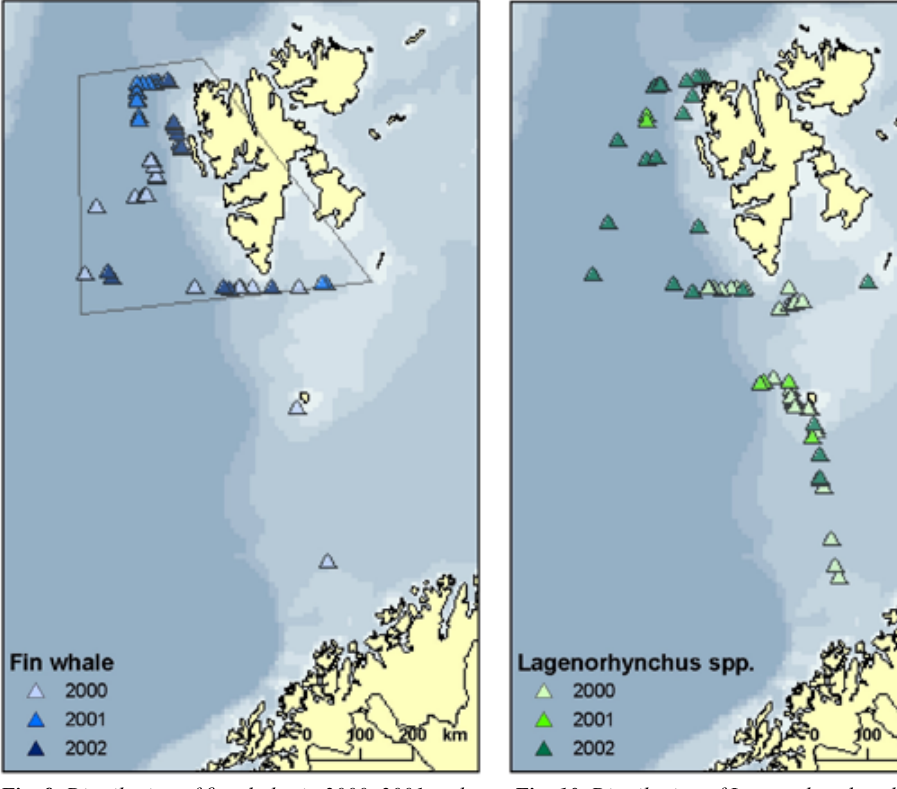
Fig. 9. Distribution of fin whales in 2000, 2001 and 2002. Polygon enclosing the defined fin whale core area is shown.